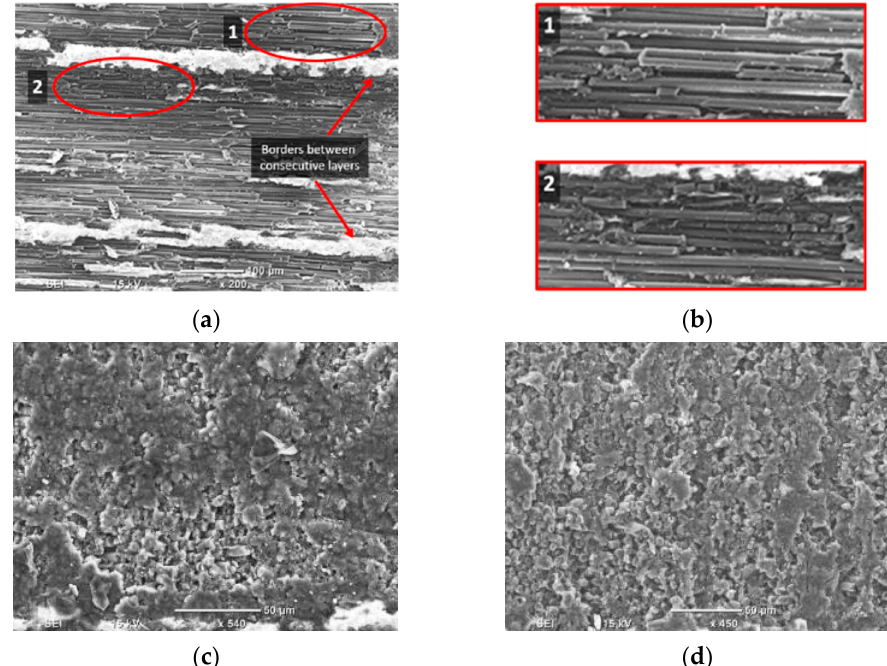
Figure 18. SEM images of the machined surface for ( a ) Experiment 4 ( θ = 0°); ( b ) magnification of Experiment 4; ( c ) Experiment 13 ( θ = 45°); and ( d ) Experiment 22 ( θ = 90°). The machining direction is from left to right.